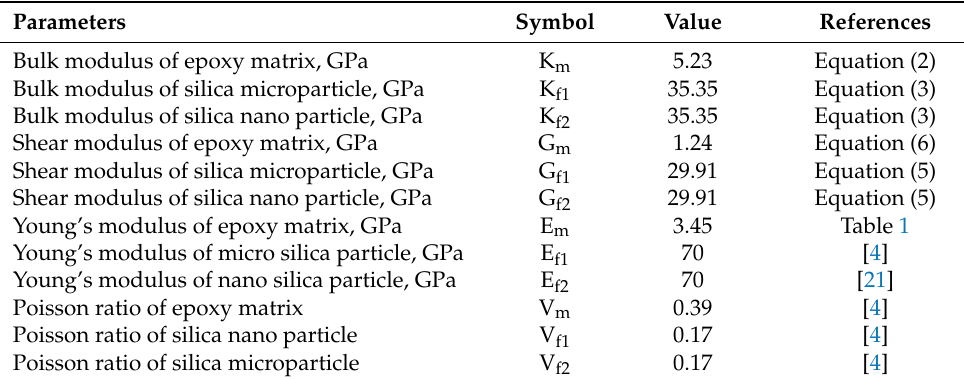
Table 3. Material parameters used in prediction and